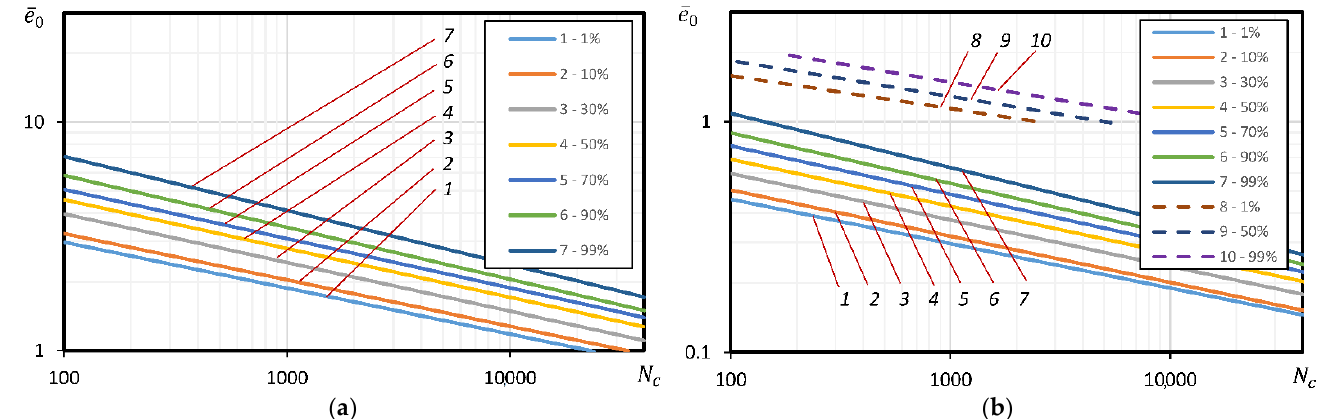
Figure 11. Comparison of the theoretical and experimental curves for the D16T1 aluminium alloy under loading with controlled strain (1 – 7 = analytical probability, 1 – 99%, straight lines; 8 – 10 = experimental probability, 1 – 99%, dashed lines): ( a ) absolute coordinates; ( b ) relative coordinates of the theoretical curve according to the Coffin dependency (Equation (11)).